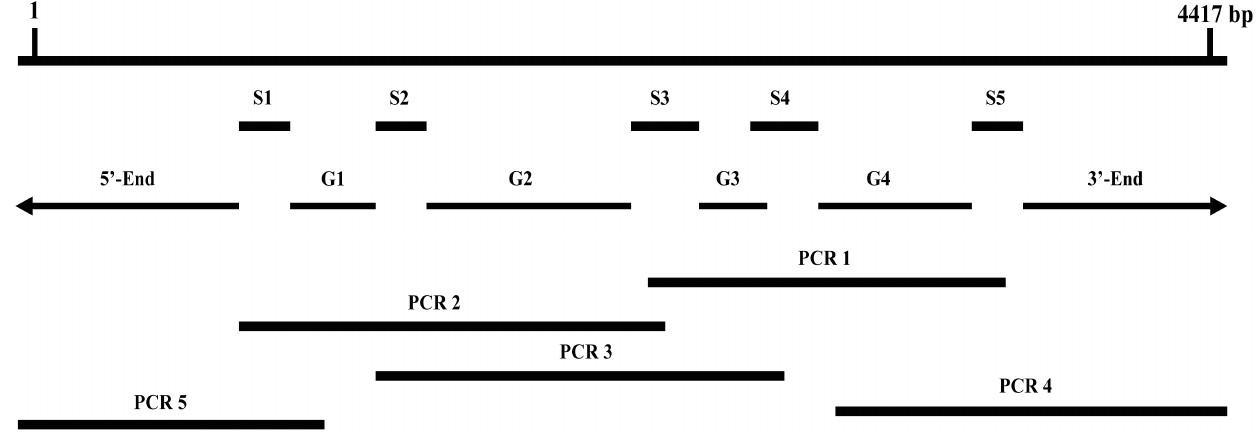
Figure 6. PCR amplification and cloning of the full-length BdCHS2 cDNA in Bactrocera dorsalis . Five PCR fragments (S1–S5) were generated from a transcriptome sequencing data of B. dorsalis . Based on S1–S5 sequences, four gaps (G1–G4) were amplified. The 3'- and 5'-end fragments were obtained through 3'- and 5'-RACE respectively. PCR1–PCR5 fragments were amplified with specific primers designed according to the assembled full-length cDNA sequences of BdCHS2